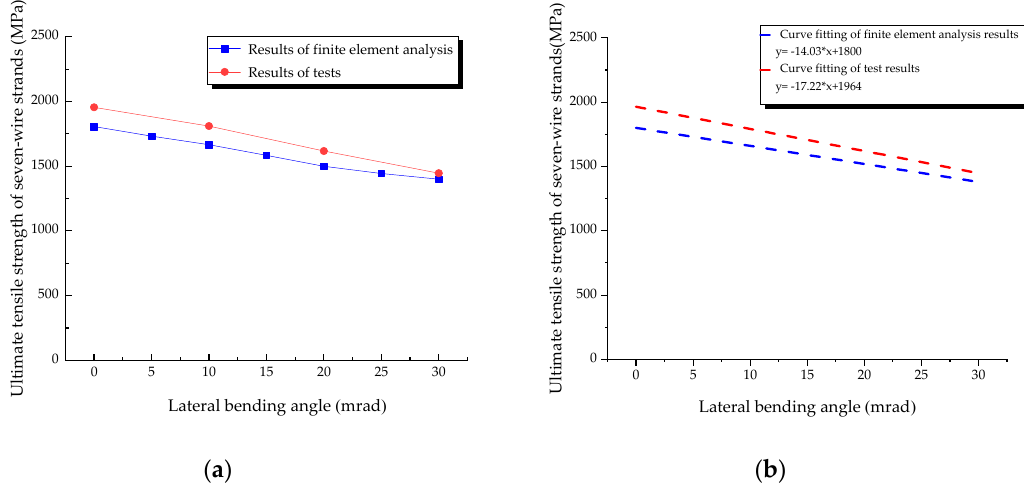
Figure 19. ( a ) The ultimate tensile strength of seven-wire strands versus lateral bending angle; and, ( b ) the curve fitting of ultimate tensile strength—lateral bending angle.